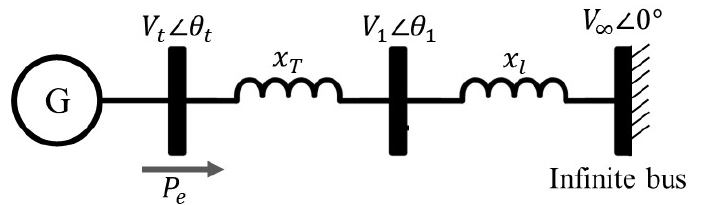
Figure 1. Single machine infinite bus power